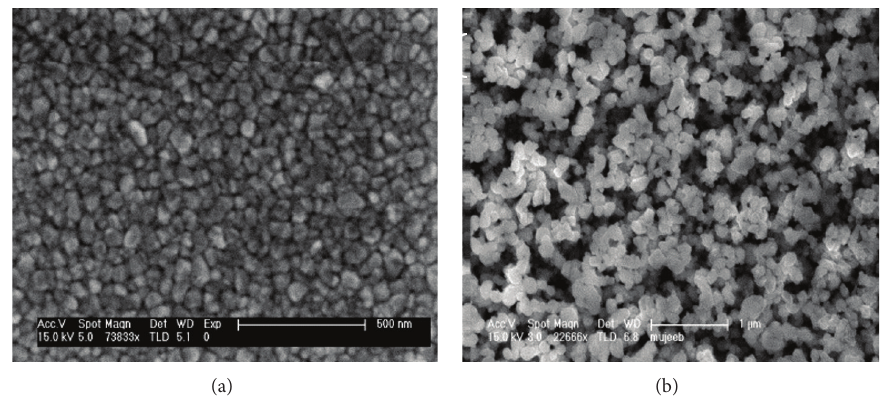
Figure 8: Thin film reference electrode materials, (a) Ag and (b) AgCl.